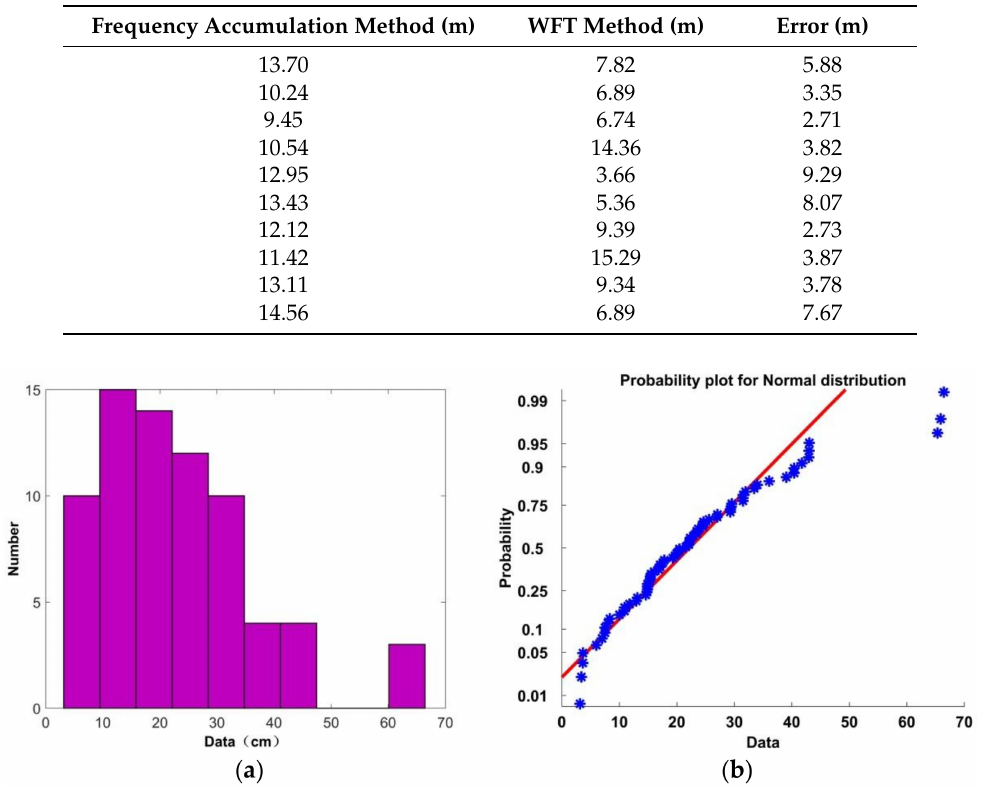
Figure 24. ( a ) Histogram of the range errors with the proposed method, and ( b ) the probability of error